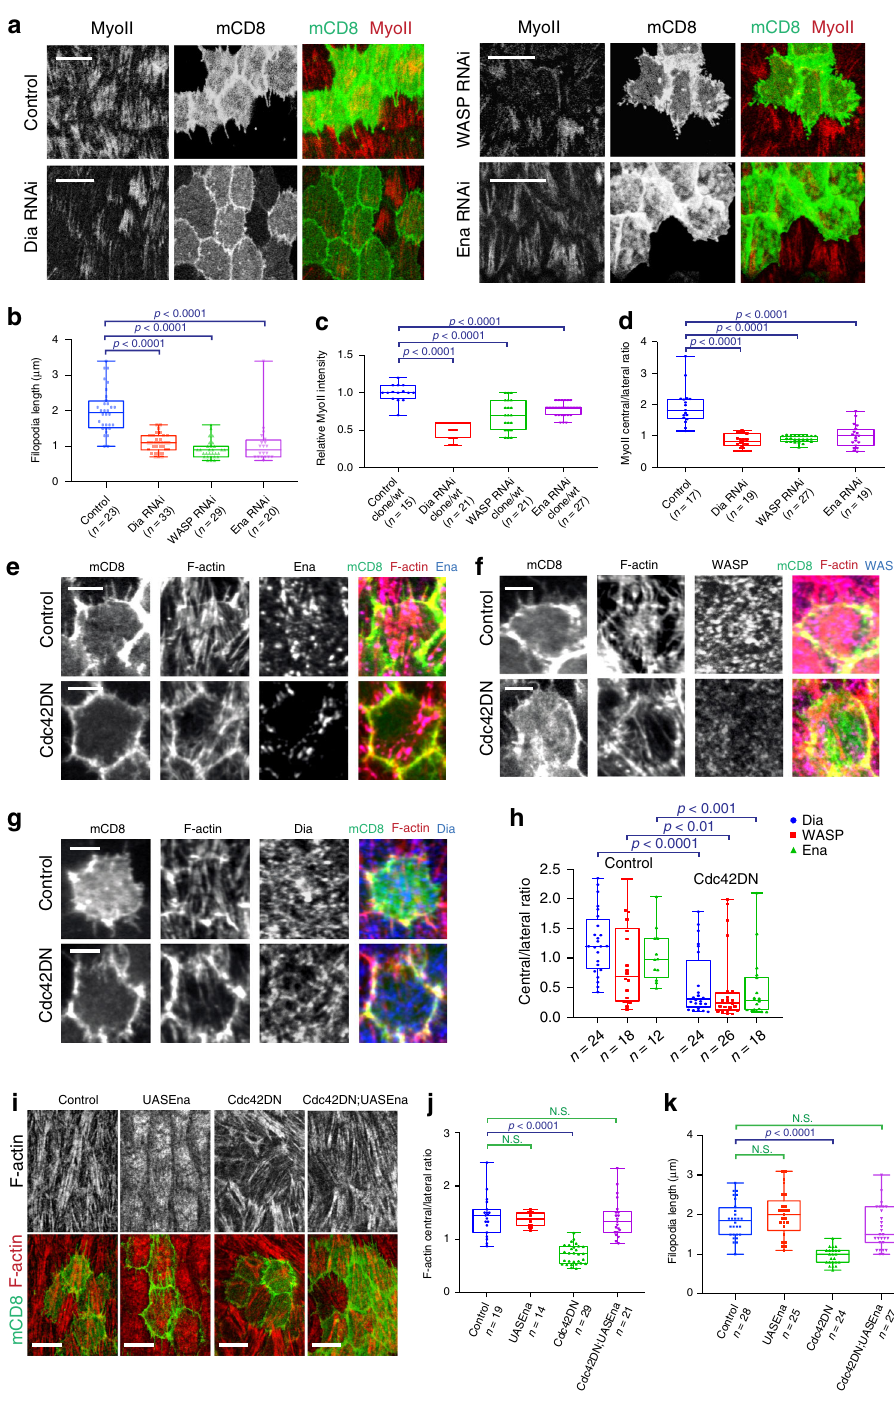
with subcellular precision 38,39 to directly probe tension anisotropy. When ablating the cell medial network along a line that is parallel to the AP direction, a maximum recoil speed of 0.22 µm s − 1 was measured on average along the DV axis (Fig. 6a, e and Supple- mentary Movie 8). When ablating along a line that is parallel to the DV direction, a maximum recoil speed of 0.01 µm s − 1 was mea- sured on average along the AP axis (Fig. 6b, e and Supplementary Movie 9). This result directly shows that tension in the medial network of follicle cells at S9 of Drosophila egg chamber devel- opment is 20 times higher along the DV axis compared to the AP axis. We next tested the role of Cdc42 in cell tension and the